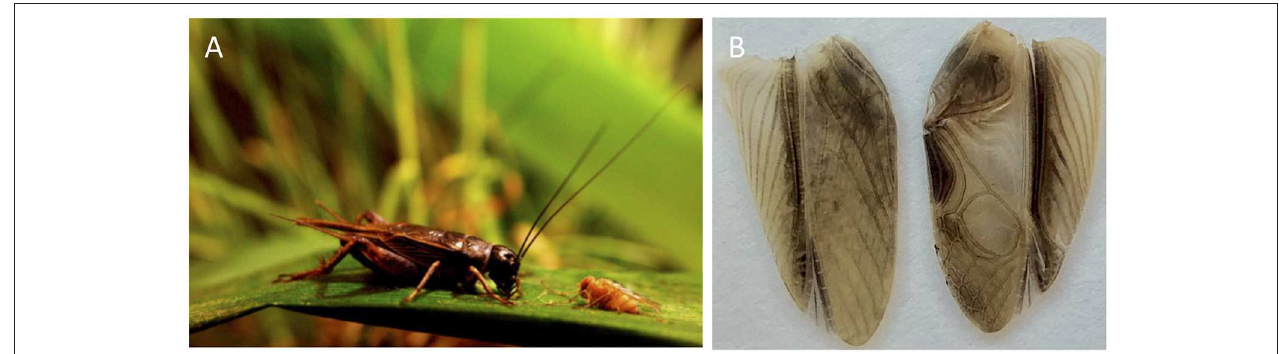
FIGURE 1 | (A) Photograph of Teleogryllus oceanicus (left) and Ormia ochracea (right); Photo courtesy of N. Lee. (B) Photograph of a cricket wing capable of song production (normal-wing; right) and a silent flatwing (left)